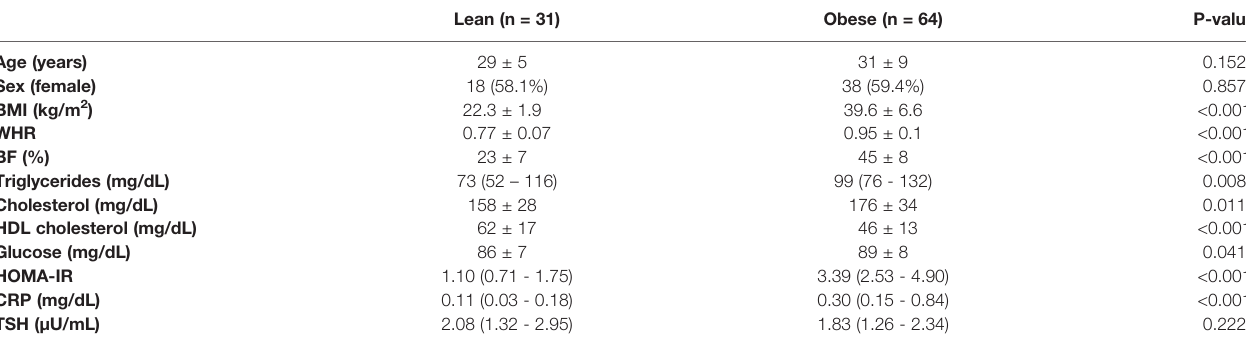
TABLE 1 | Baseline characteristics of the study